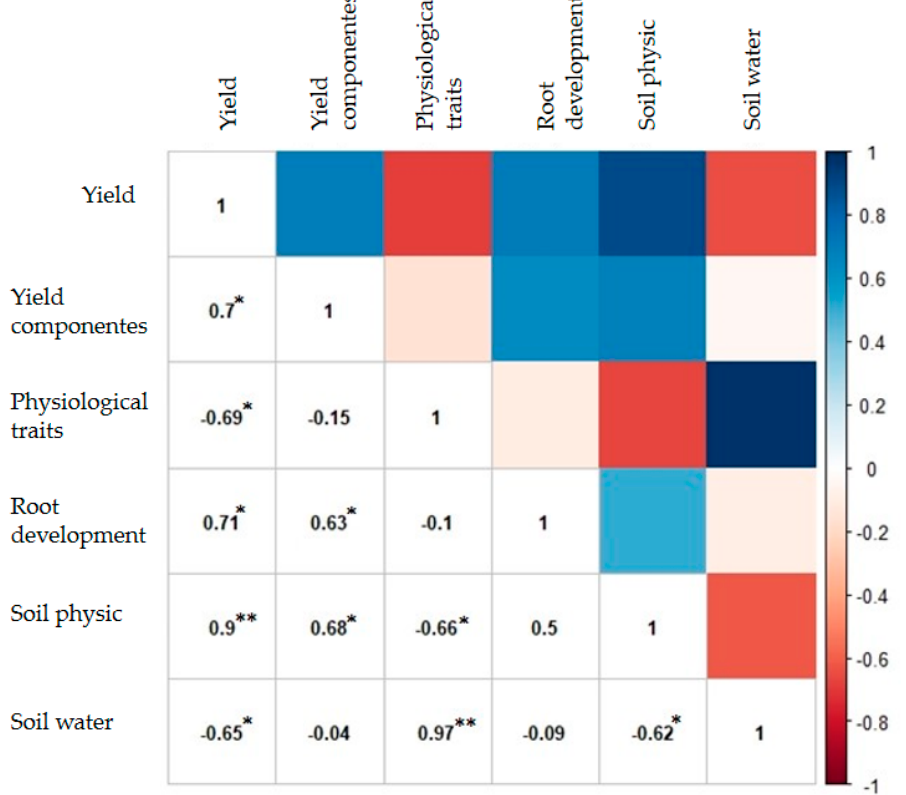
Figure 3. Pearson correlation between the first principal component of each variable group. ** and * indicates significant correlation at p < 0.01 and p < 0.05, respectively.